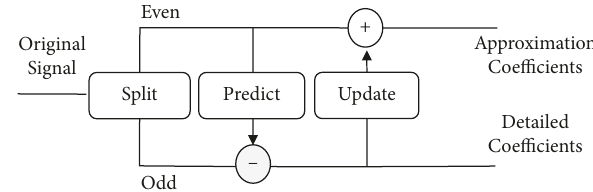
Figure 1: Forward lifting wavelet transform.